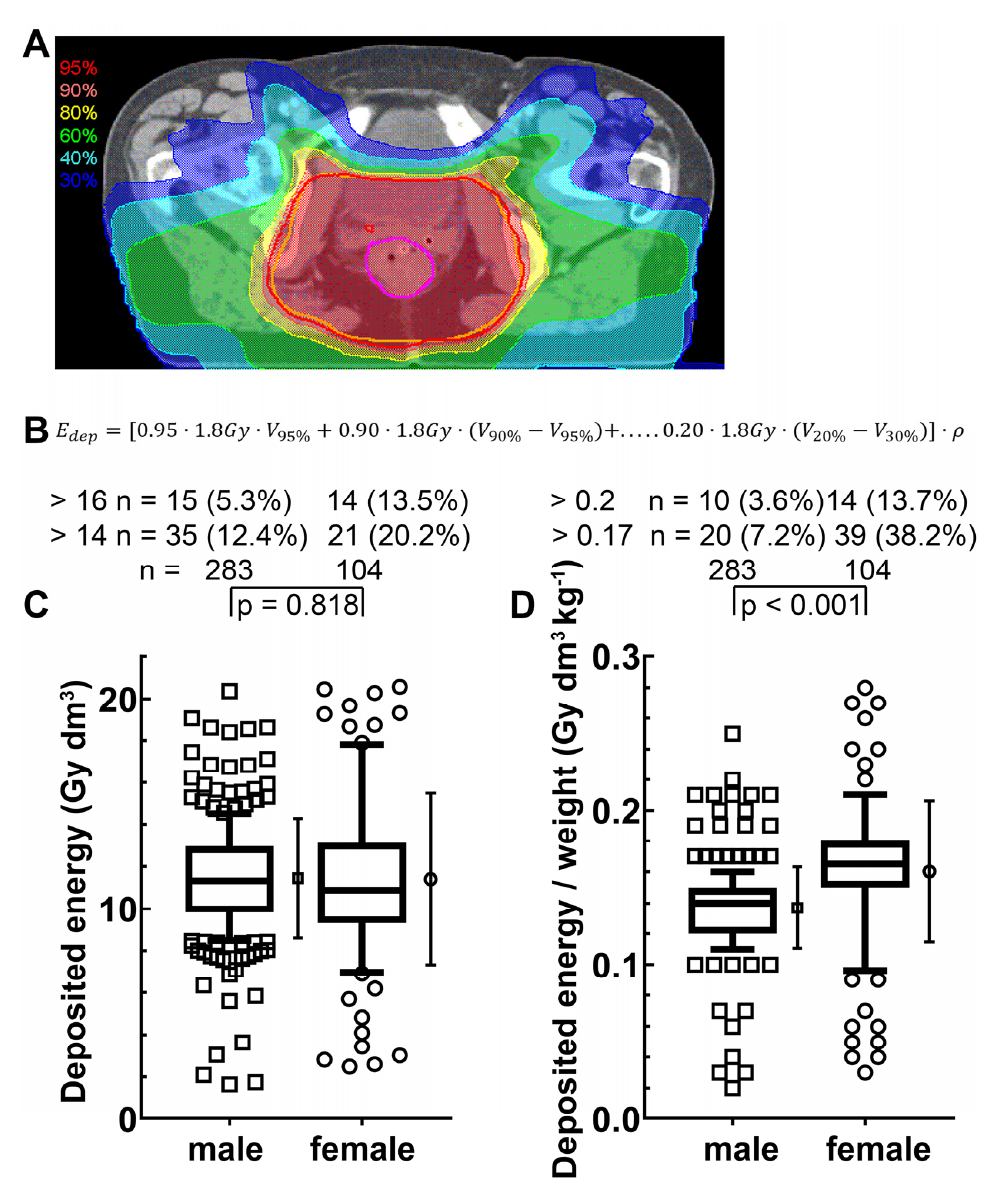
Figure 3. Deposited energy in patients with rectal cancer (radiosensitivity cohort): ( A ) Treatment plan of a patient with rectal cancer where the isodose ranges are marked with different color wash. The magenta line represents the gross target volume; the inner yellow line represents the planning target volume; ( B ) The deposited energy (Edep) is calculated using the equation given, where V is the volume and ρ is the density; ( C ) The deposited energy and ( D ) The deposited energy related to body mass in the cohort. The box represents the 25th to 75th percentiles and the whiskers represent the 10th to 90th percentiles. The mean and standard deviation are shown to the right of the box; p - values were calculated by the Student’s t -test.